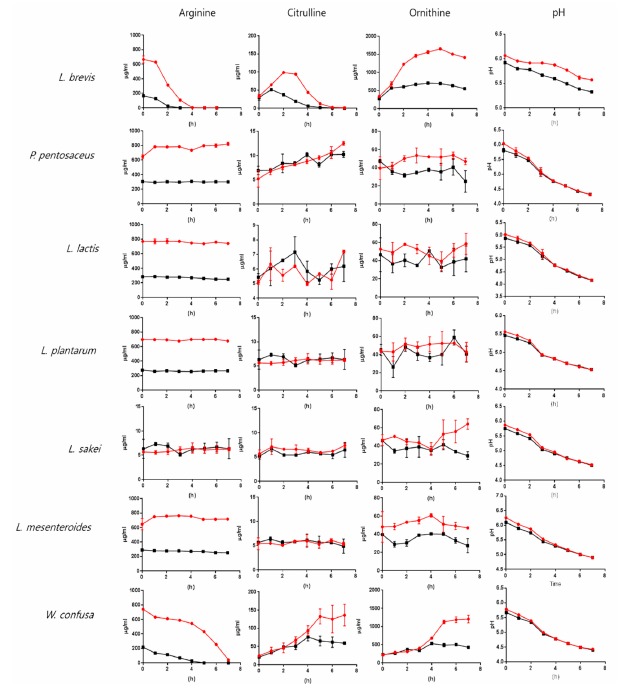
Figure 3. Analysis of citrulline and ornithine production by lactic acid bacteria. MRS medium samples were prepared by adding 500 μ g/mL arginine (the red line), and the bacteria were cultivated at 30 °C. The arginine, citrulline, and ornithine contents were measured by LC-MS. L. brevis and W.